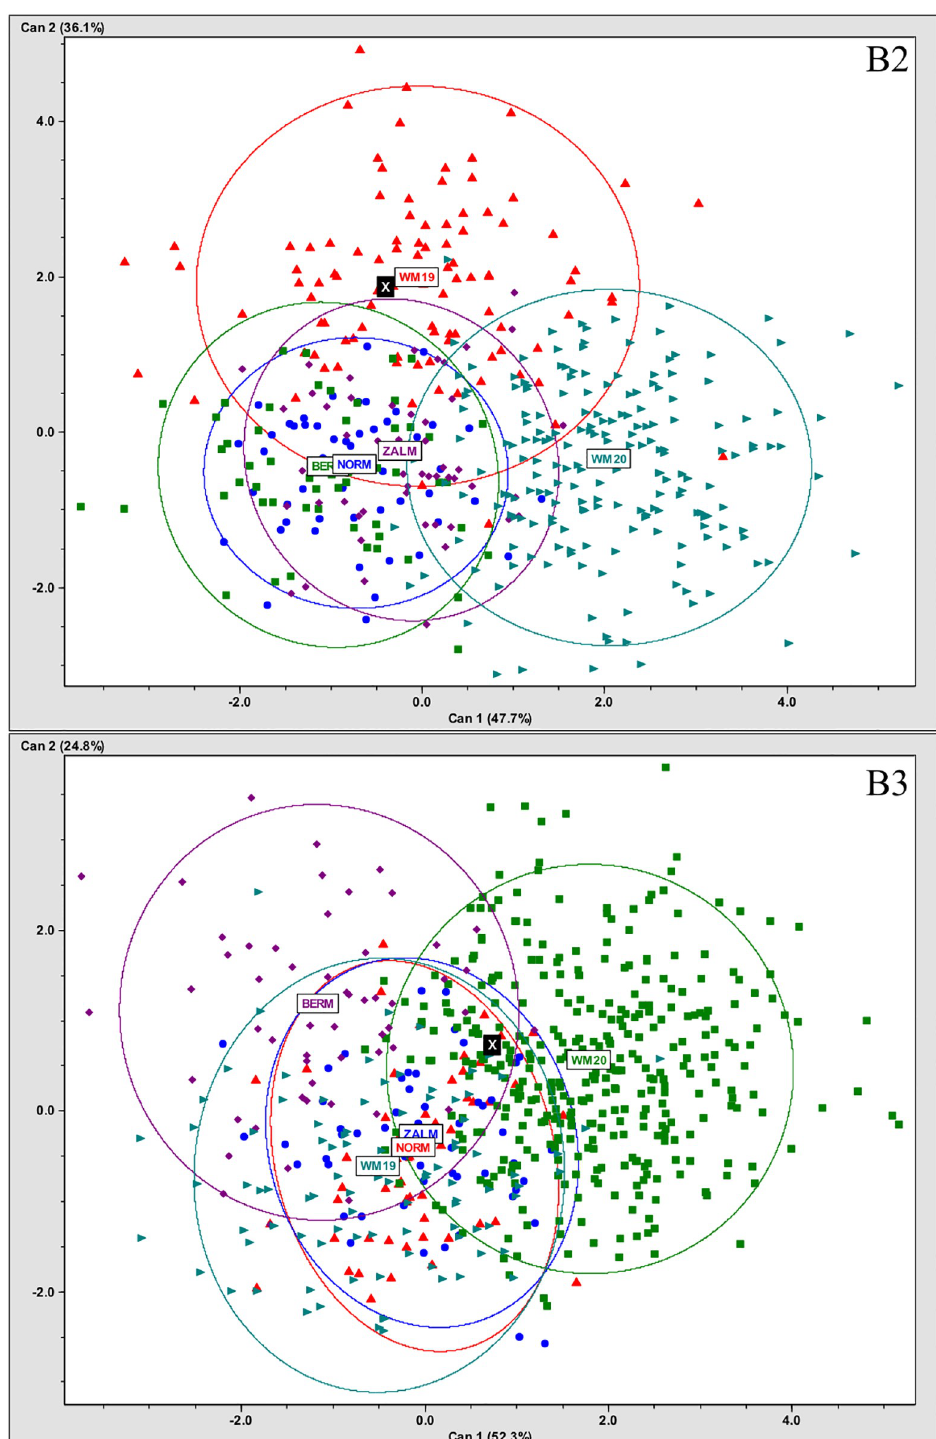
Fig 9. Ancestry estimations for YNH4 individual B2 (top) and B3 (bottom). “X” indicates YNH4 individual location. See S4 Table for data and abbreviations.